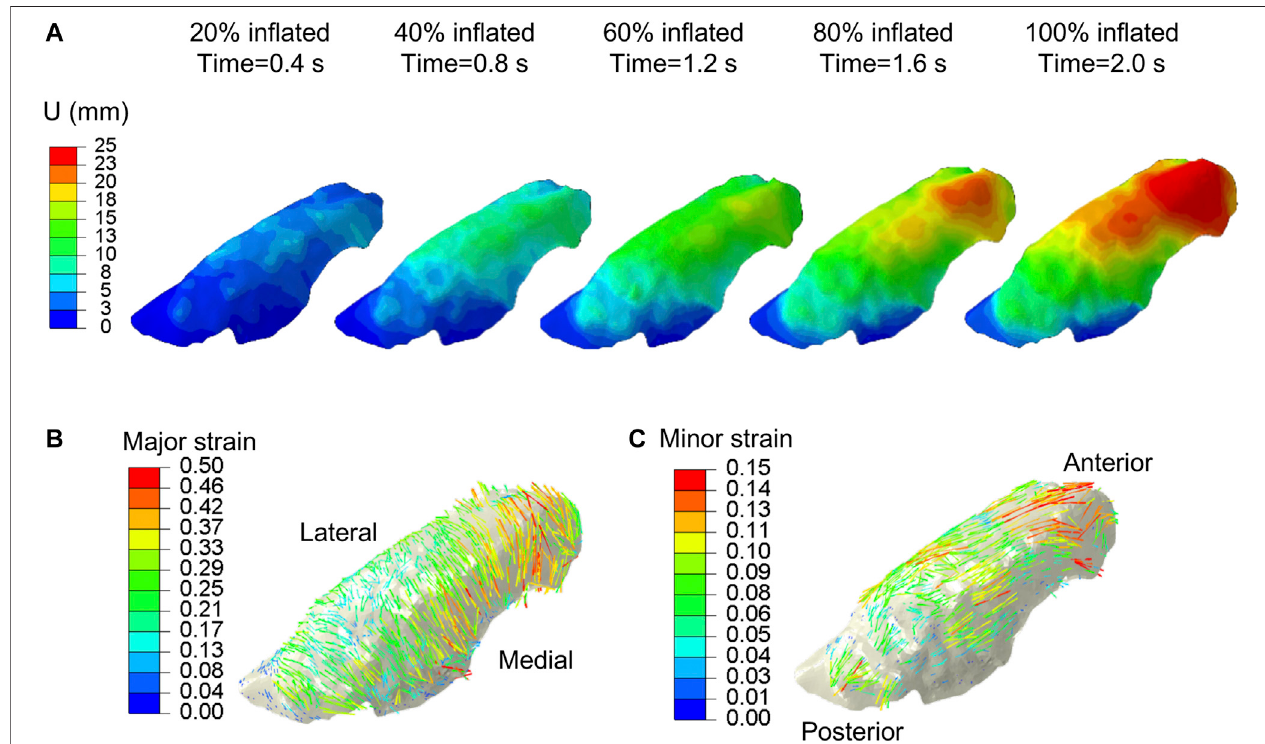
FIGURE3| DICmeasureddisplacementsdata,extracted at ∼ 7,000evenlydistributedpointsacrosstheparenchymalsurfacewereinterpolatedandappliedtothe FE model. (A) Displacement magnitude contour maps corresponding to fi ve increments of 20% in fl ation steps. Anterior regions of the lung exhibited the largest distensions. Vector fi eld map of major (B) and minor (C) strains were obtained from imposing interpolated DIC displacements to the model.